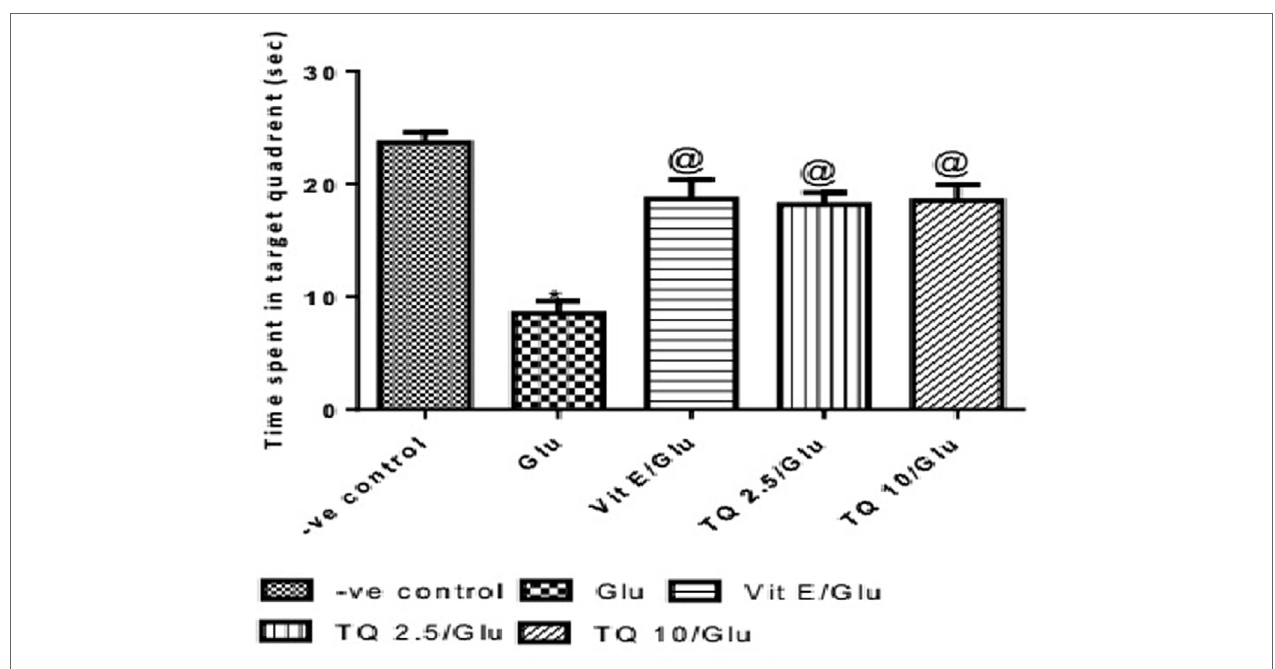
FigUre 8 | Effect of − ve control, Glu, Vit E/Glu, TQ2.5/Glu, and TQ10/Glu on A β (1–42) levels. Glu was injected i.p. as a single dose for 7 days. TQ and Vit E were injected as a single dose for 7 days. Each value represents the mean value of 12 rats ± SEM. Statistics were carried out by one-way ANOVA followed by Tukey’s multiple comparison tests, by graph pad prism 5. *Statistically significant from − ve control group ( p < 0.05); @ statistically significant from Glu group ( p < 0.05); # statistically significant from Vit E/Glu group ( p < 0.05); X statistically significant from TQ 2.5/Glu group ( p <